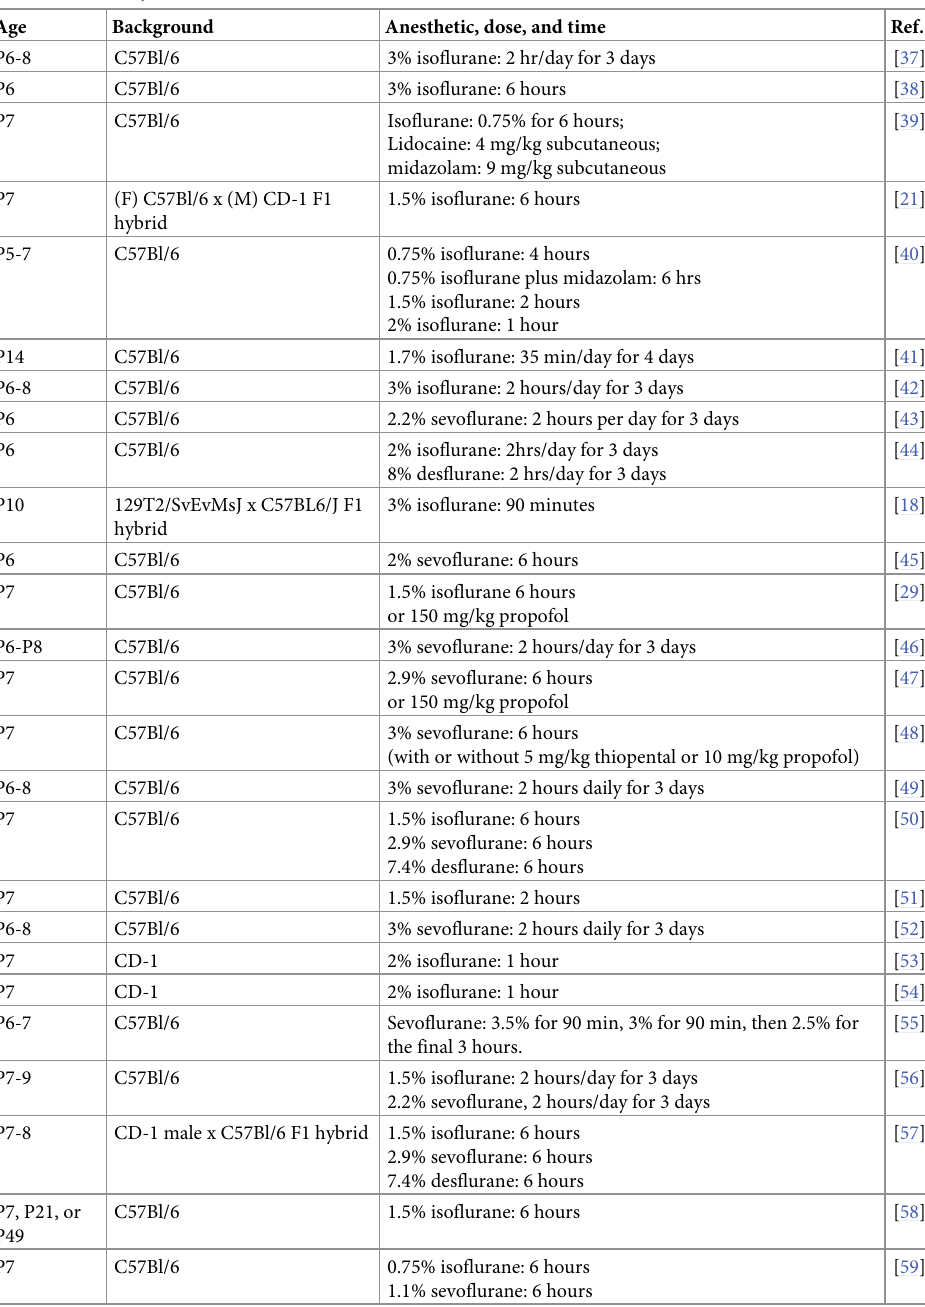
Table 1. Summary of neonatal mouse AIN